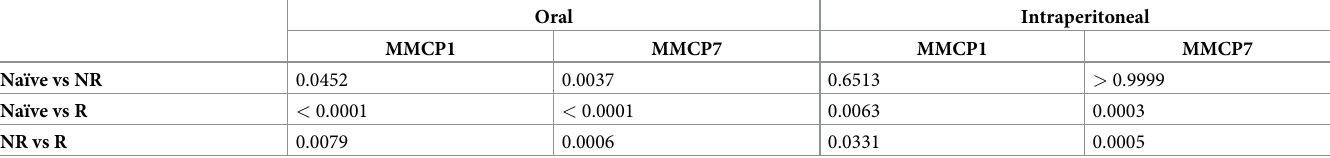
Table 5. Adjusted p values comparing MMCP-1 and MMCP-7 levels between naïve, non-responder (NR) and responder (R) Balb/c mice after oral or intraperitoneal